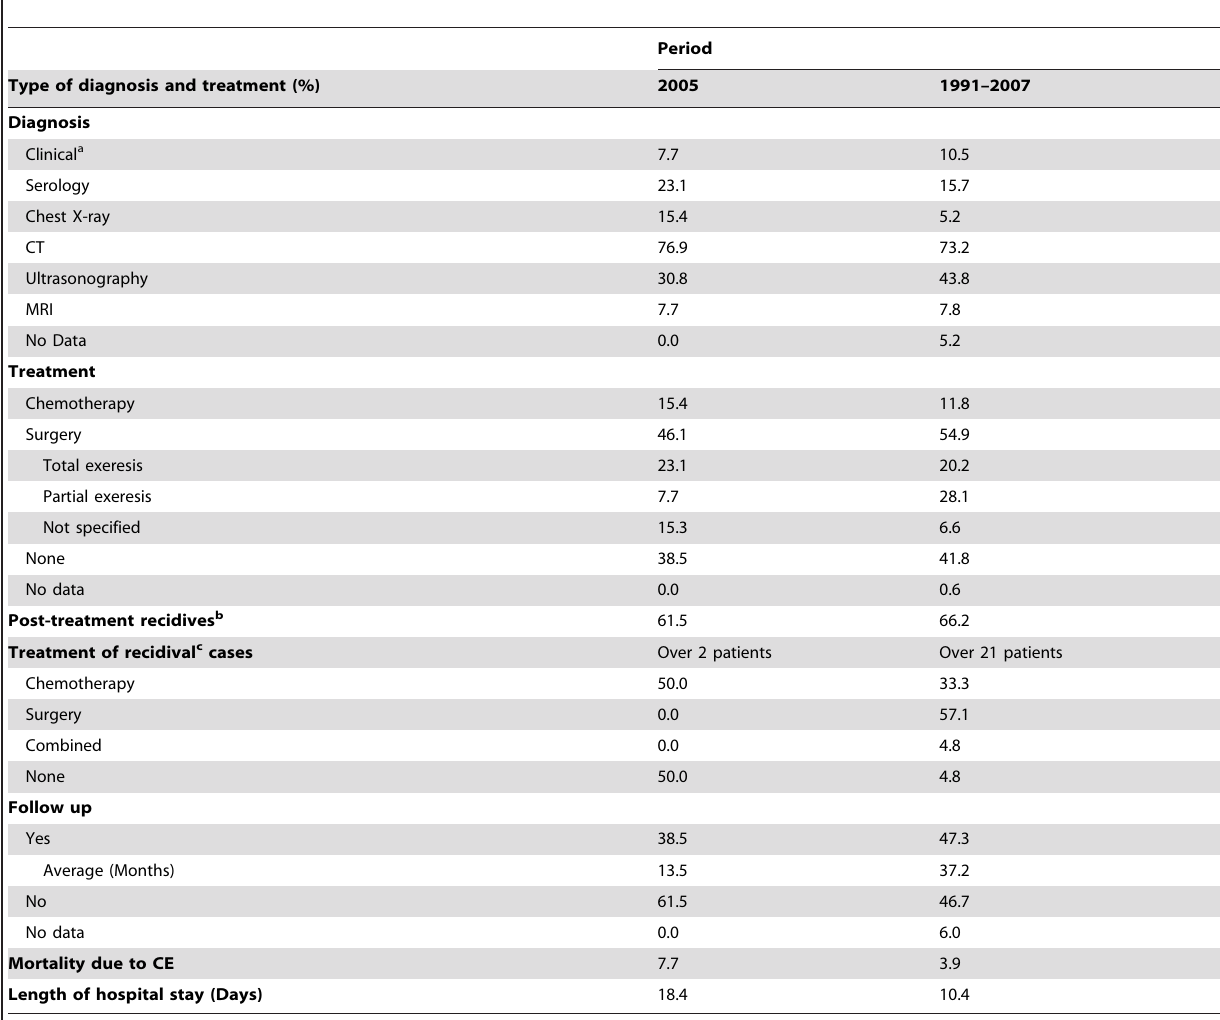
Table 1. Distribution of diagnostic tests and treatments received by diagnosed human CE cases in 2005 (13 cases) and for the period between 1991 and 2007 (154 cases) in the two major hospitals capturing all CE cases in A´lava.